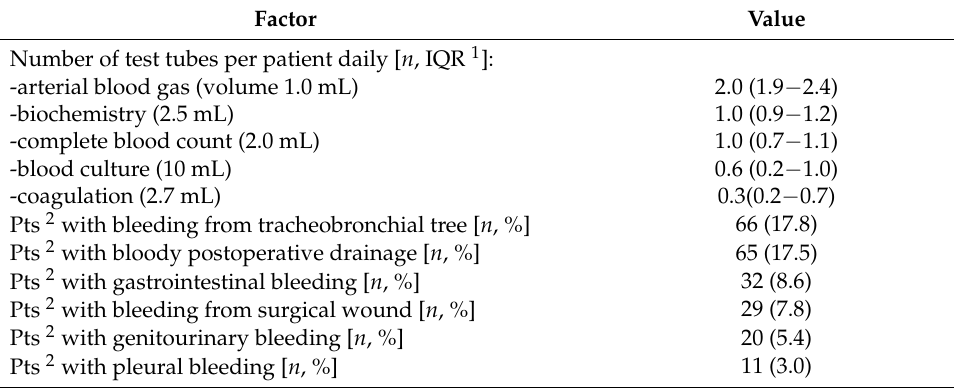
Table 5. Other factors contributing to iatrogenic blood loss.